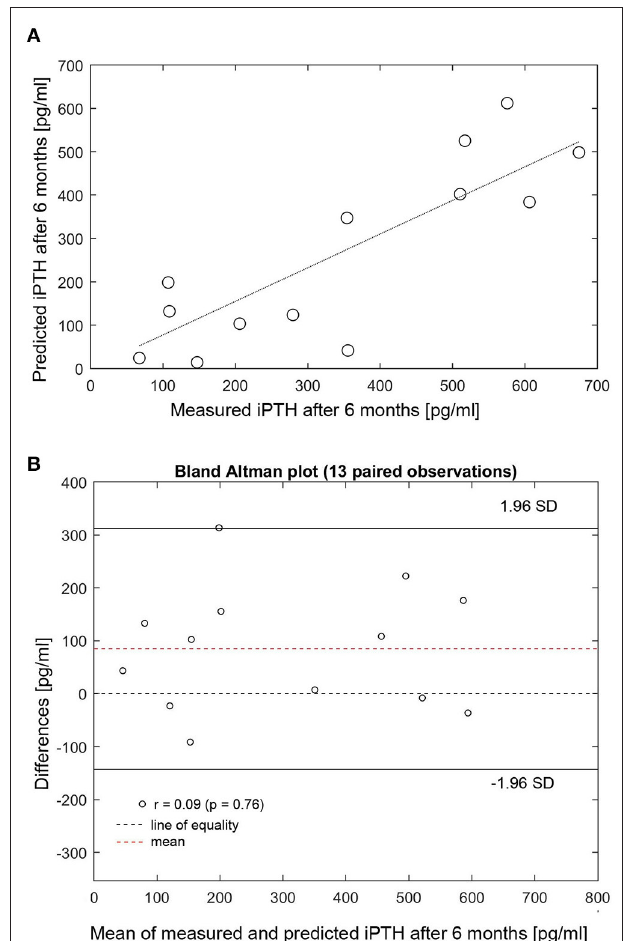
FIGURE 4 | (A) Correlation between measured and predicted 6-months iPTH ( n = 13). ( B) Bland Altman plot for differences between measured and predicted 6-months iPTH. (A) Measured (x-axis) and predicted (y-axis) 6-months iPTH (r = 0.848, p < 0.001). HD, hemodialysis; iPTH, intact parathyroid hormone; SD, standard